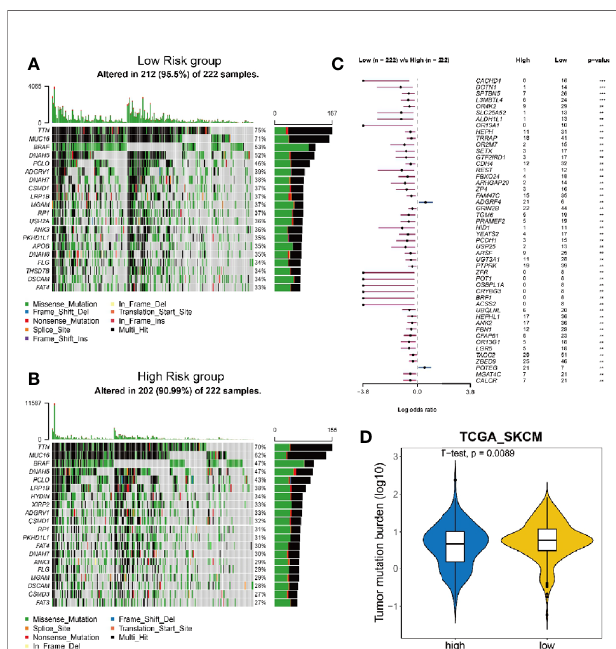
FIGURE 5 | Analysis of mutation burden in high and low risk group. (A, B) Mutation landscape of 222 melanoma tumor samples with low risk (A) and high risk (B) . Central matrix shows somatic mutations with colors indicating different types of mutations and genes mutated at high frequency are represented in the left list. The top bar plot shows the number of gene mutations in each sample and the mutation rate of signi fi cantly mutated genes is displayed on the right. (C) Comparison of mutation frequency between high risk group and low risk group. (D) Comparison of tumor mutation burden between high risk group and low risk